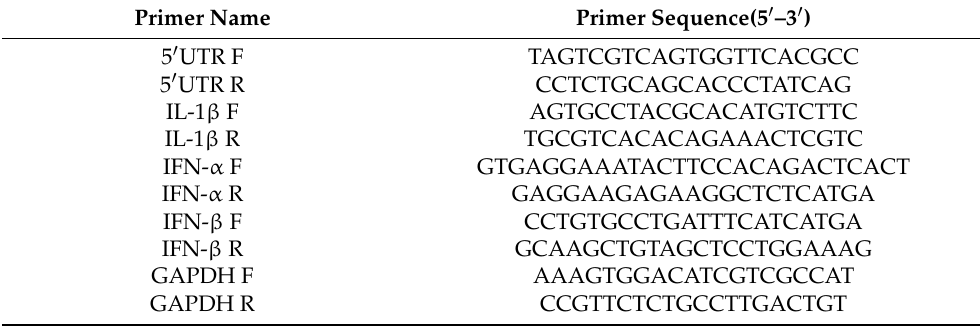
Table 1. Sequences of primers used for